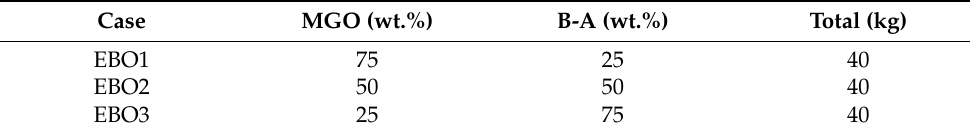
Table 1. Blending ratios of all cases for ultrasonic irradiation experiments.